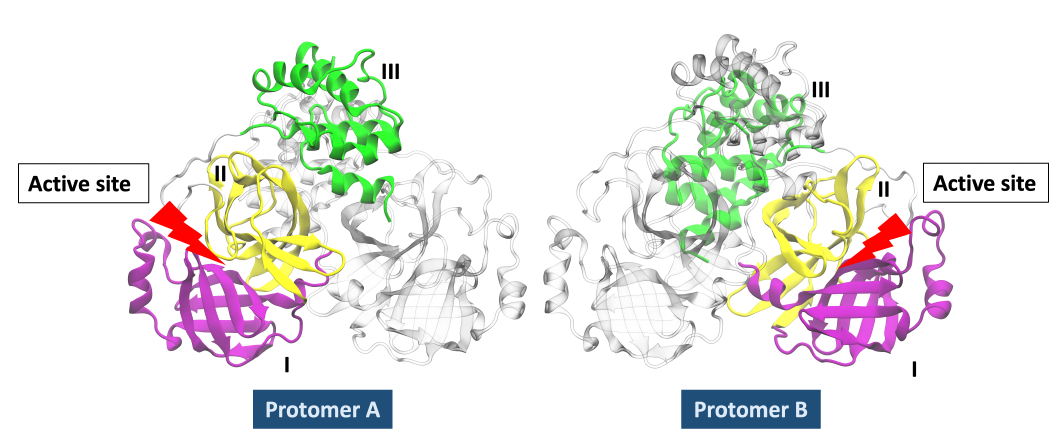
Figure 1. SARS-CoV-2 Mpro, PDB ID: 5RE4. Domain I in purple colour, domain II in yellow colour and domain III in green